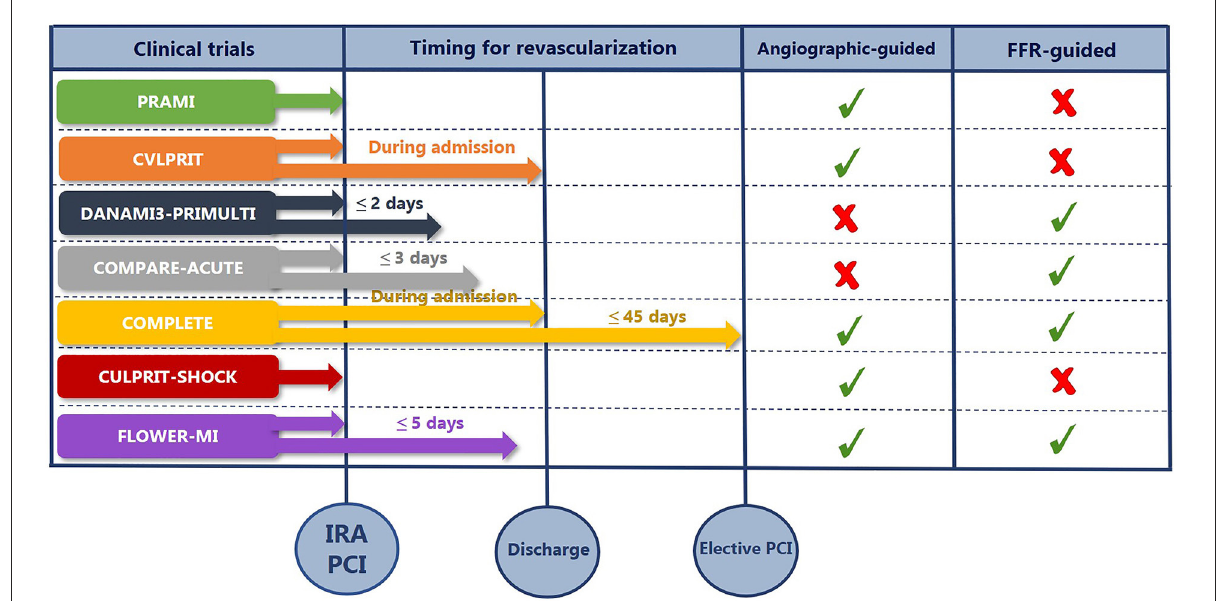
FIGURE1 The summary of timing for complete revascularization and the method of guidance for PCI. COMPARE-ACUTE, Comparison Between FFR Guided Revascularization vs. Conventional Strategy in Acute STEMI Patients With MVD; COMPLETE, Complete vs. Culprit-Only Revascularization Strategies to Treat Multivessel Disease after Early PCI for STEMI; CULPRIT-SHOCK, Culprit Lesion Only PCI vs. Multivessel PCI in Cardiogenic Shock; CVLPRIT, Complete vs. Lesion-only Primary PCI; DANAMI3-PRIMULTI, Primary PCI in Patients With ST-elevation Myocardial Infarction and Multivessel Disease: Treatment of Culprit Lesion Only or Complete Revascularization; FFR, fractional flow reserve; FLOWER-MI, FLOW Evaluation to Guide Revascularization in Multi-vessel ST-elevation Myocardial Infarction IRA, infarct-related artery; PCI, percutaneous coronary intervention; PRAMI, Preventive Angioplasty in Acute Myocardial Infarction.